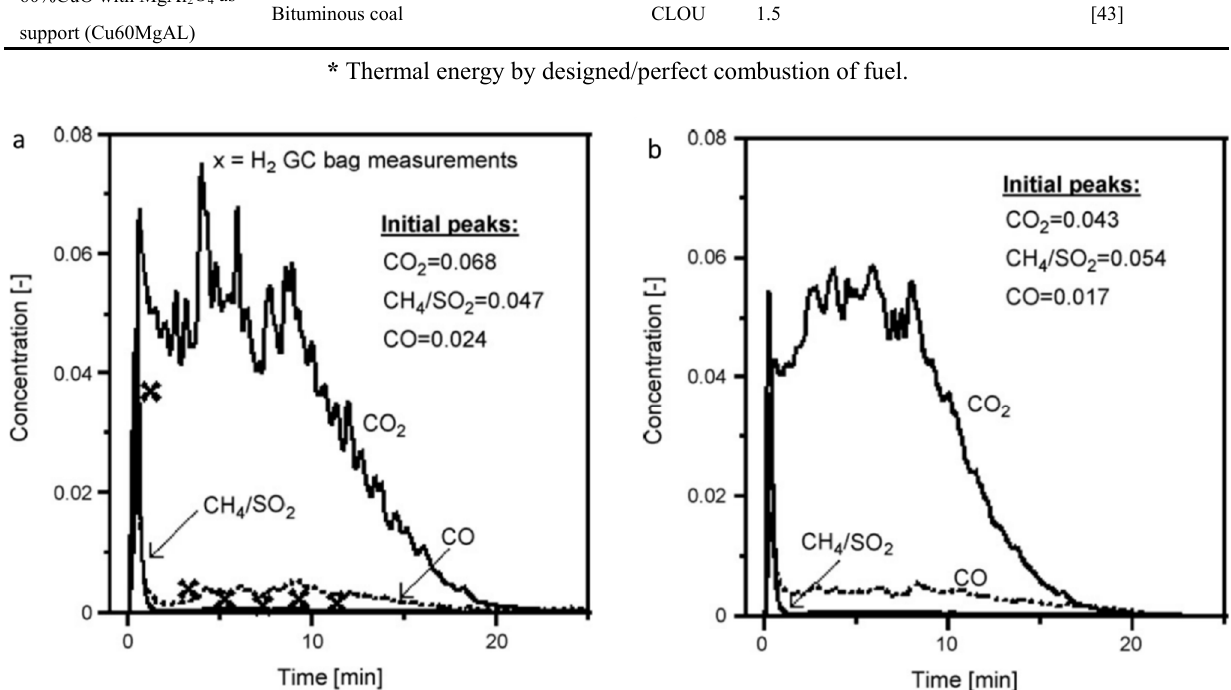
Figure 6. Produced gas concentrations after condensations water vs. time during the reduction of 40 g Fe 2 O 3 /MgAl 2 O 4 ( a ) and 40 g ilmenite ( b ) with 0.2 g petroleum coke at 950 °C with 50% of H 2 O